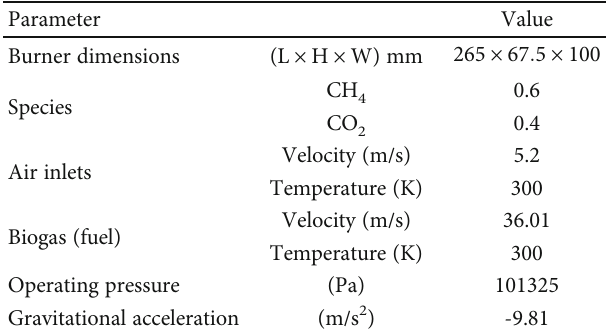
Table 2: Model input data of the burner.